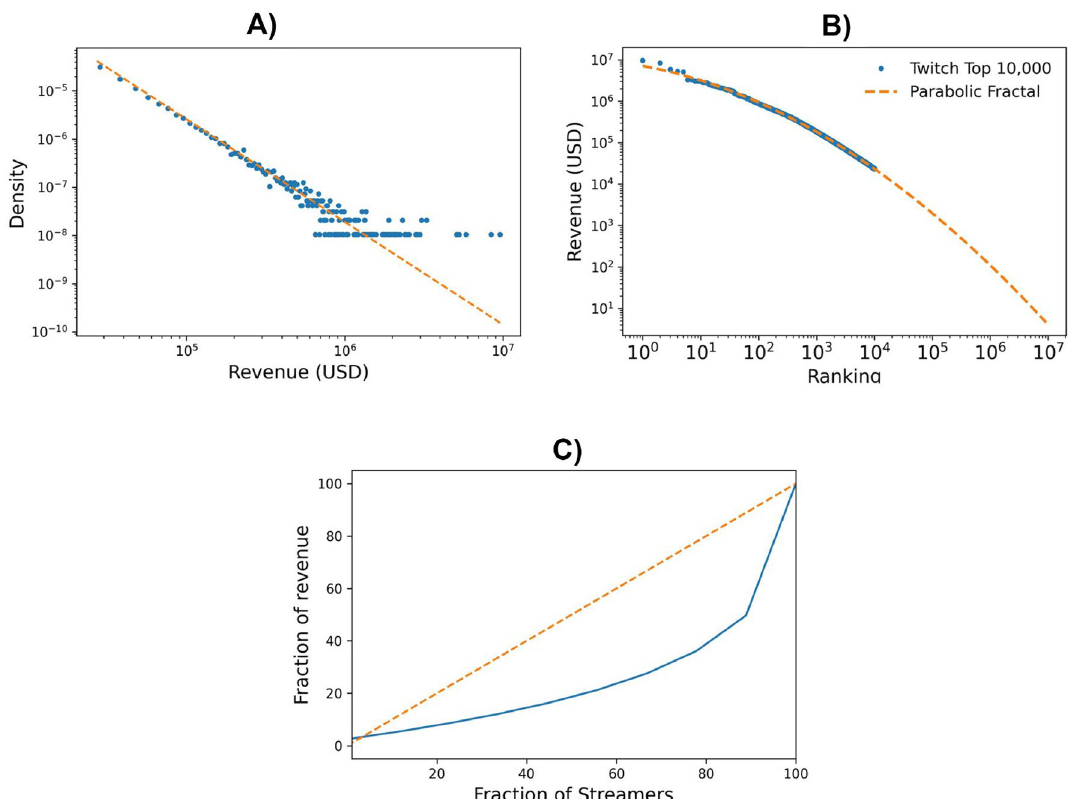
Figure 1. Inequalities in the streamers revenue from Twitch platform illustrated in three different ways. ( A ) The Revenue distribution for all 10,000 streamers between August 2019 and October 2021 (in US$). The distribution function appears long tailed and can be fit with a power law with exponent − 2.13. The Gini index associated with this distribution is ≈ 0.57. ( B ) Rank plot of Streamers revenue (in US$). Here, the curve is fit − b ) − c log ( x ) 2 + norm with a parabolic fractal function (orange dashed line, y = log ( x , with parameters, b ≈ 0.259, c ≈ 0.0392, norm ≈ 15.78). Using the fit we could extend our estimate for the Gini index to all 9.2 million streamers present in the platform, for which we find the considerably larger value of ≈ 0.93. ( C ) Lorentz curve of streamers revenue, with perfectly equal distribution. Actual revenue distribution against perfectly equal